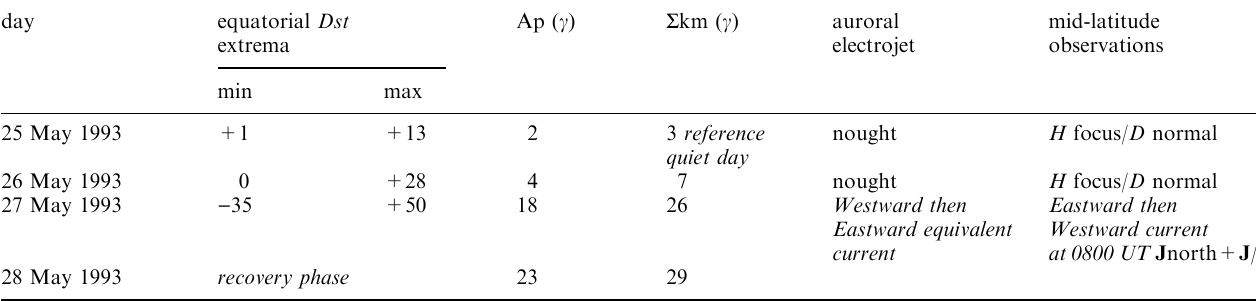
Ap ( (cid:99) ) (cid:83) km ( (cid:99) )